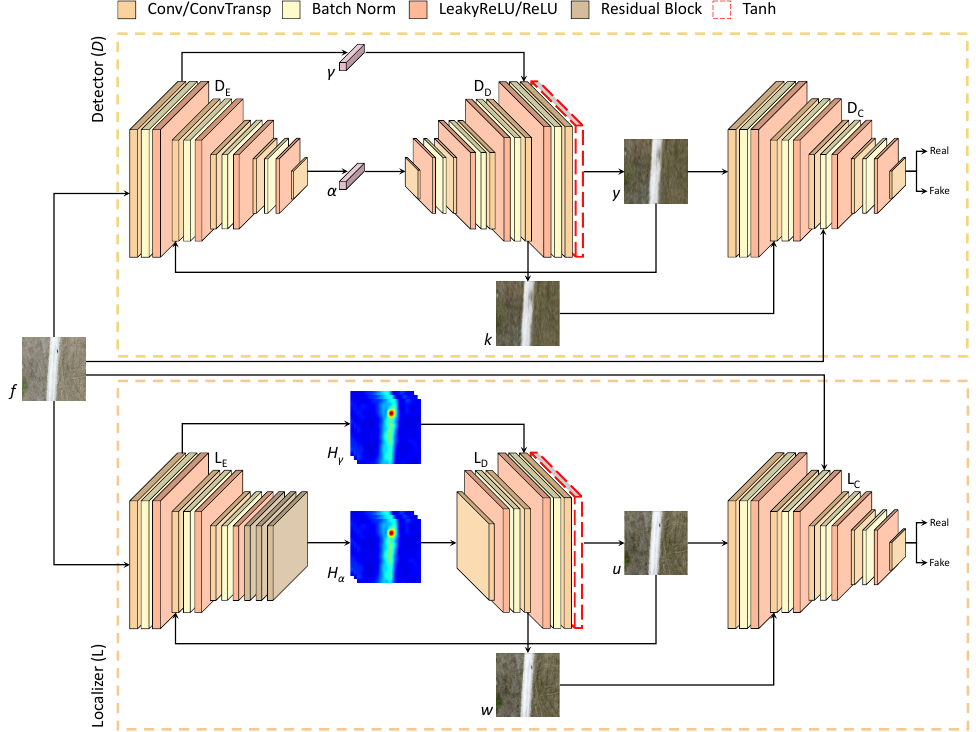
Figure 1. The proposed two-branch network architecture. Given an anomalous scene as input, the top GAN (i.e., the detector) detects if anomalies are present or not. The bottom GAN (i.e., the localizer), instead, localizes and highlights the anomalous regions when